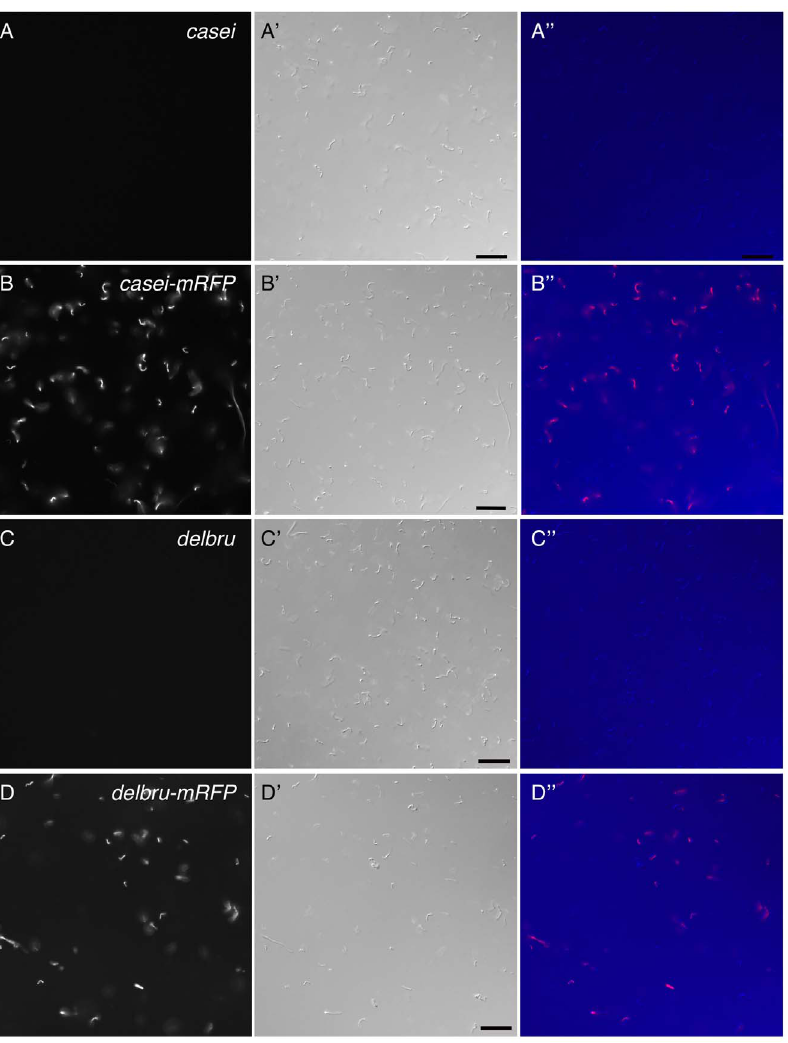
Figure 3. mRFP1 can be expressed broadly in Lactobacillus. The pLEM415-ldhL-mRFP1 vector was transformed into L. casei (B) and L. delbrueckii (D). mRFP1 was detected in both strains. Wild type strains were used as control (A,C). mRFP1 expression (red) is shown in the left panels and DIC images (purple) in the middle. Merged views are shown in the right panels. Scale bars, 20 m m.